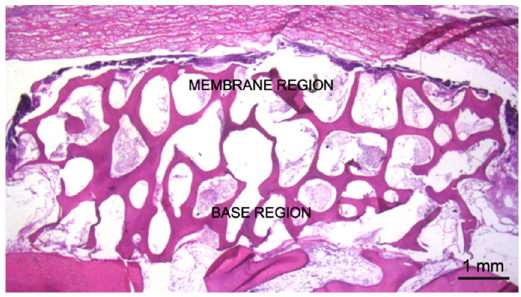
Figure 3. Membrane and Base regions analyzed histologically.